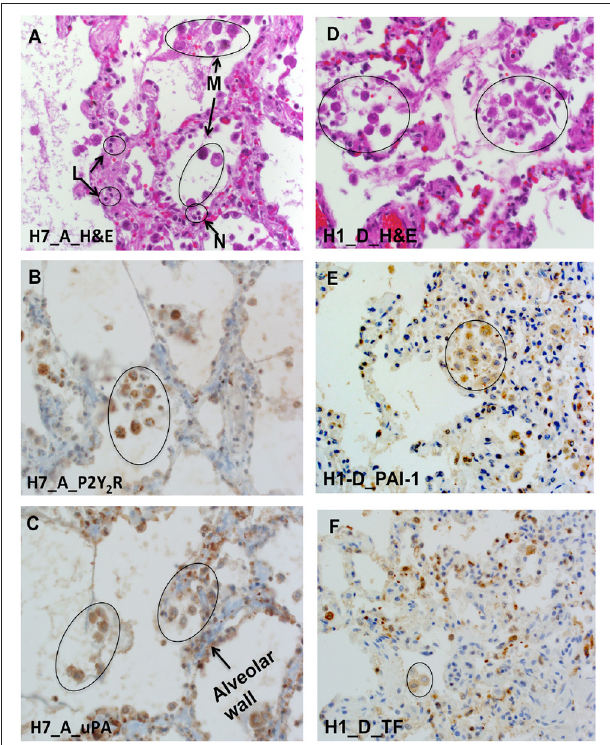
FIGURE 7 | P2Y 2 R, uPA, PAI-1, and TF colocalize with macrophages in serial HCPS lung tissue sections. (A) Micrograph of lung tissue of HCPS patient (case H7 Block A) stained with hematoxylin and eosin (H&E) showing alveolar macrophages, neutrophils, and lymphocytes. (B) Immunohistochemical- detection of P2Y 2 R expression on macrophages and type 2 pneumocytes (H70 antibody: SC-20124). (C) Positive antigen staining for uPA in type II pneumocytes, hyaline membranes, alveolar macrophage (circles) (original magnification × 400). (D) H & E image of lung section of an HCPS patient (case H1 Block D) highlighting hyaline alveolar membranes, and macrophages in circles. (E,F) Serial Lung sections of case H1 Block D reveal cellular localization of PAI-1 and TF. PAI-1 mostly associated with macrophages and type II pneumocytes. PAI-1 was detected with the H135 antibody, Sc-8979 (Santa Cruz). TF staining was localized with alveolar macrophages or distributed in type II pneumocytes. Tissue factor (TF) was detected by a rabbit monoclonal antibody EPR8986 ab151748 (Abcam) (original magnification for all slides × 400).